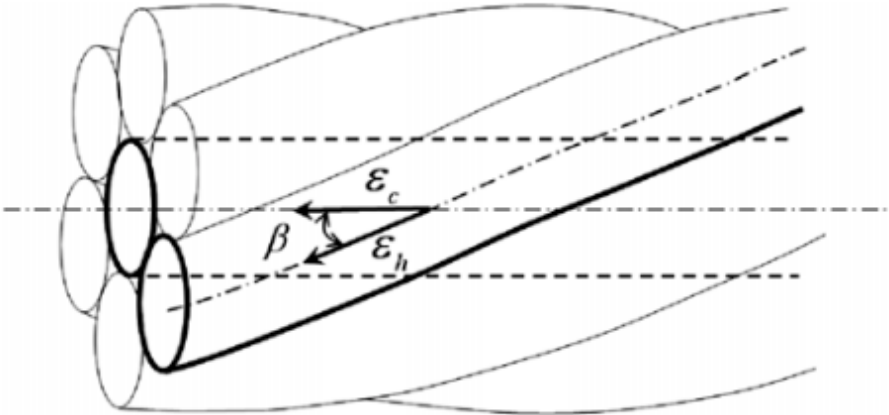
Figure 6. Strain relationship and lay angle [28]. Reprinted/adapted with permission from Ref. [28]. 2010, Elsevier.